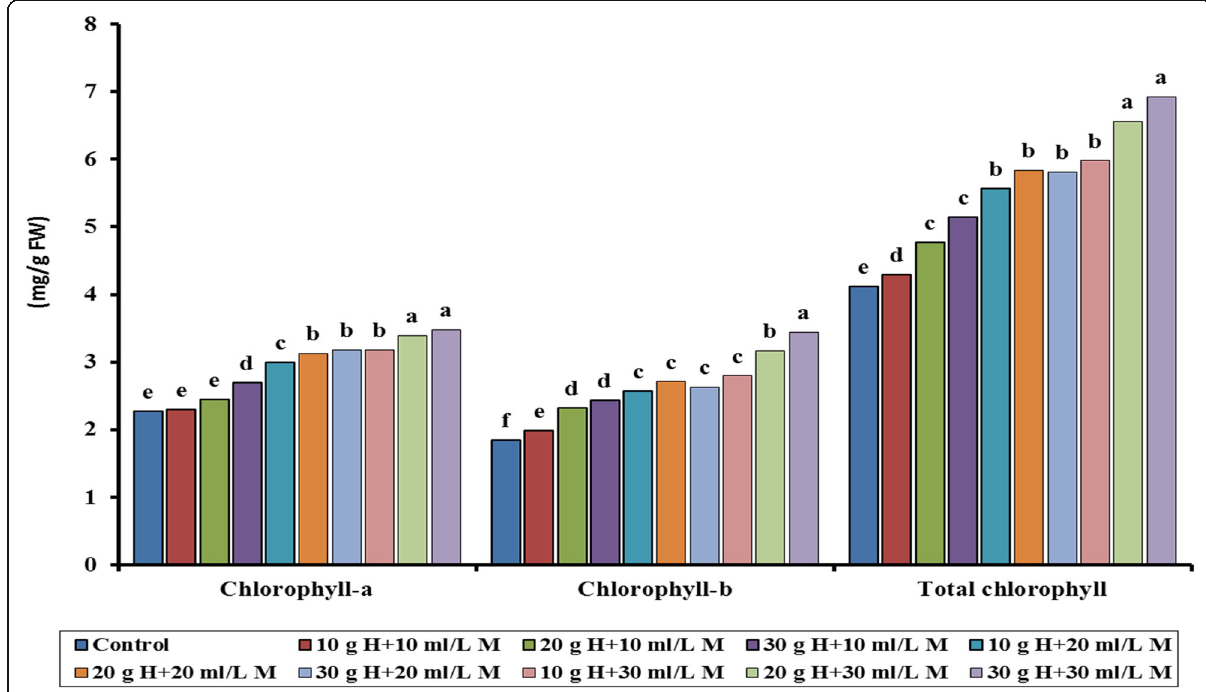
Fig. 1 Effect of soil applications with humic acid and foliar spray of milagro on chlorophyll-a, chlorophyll-b, and total chlorophyll during the first season